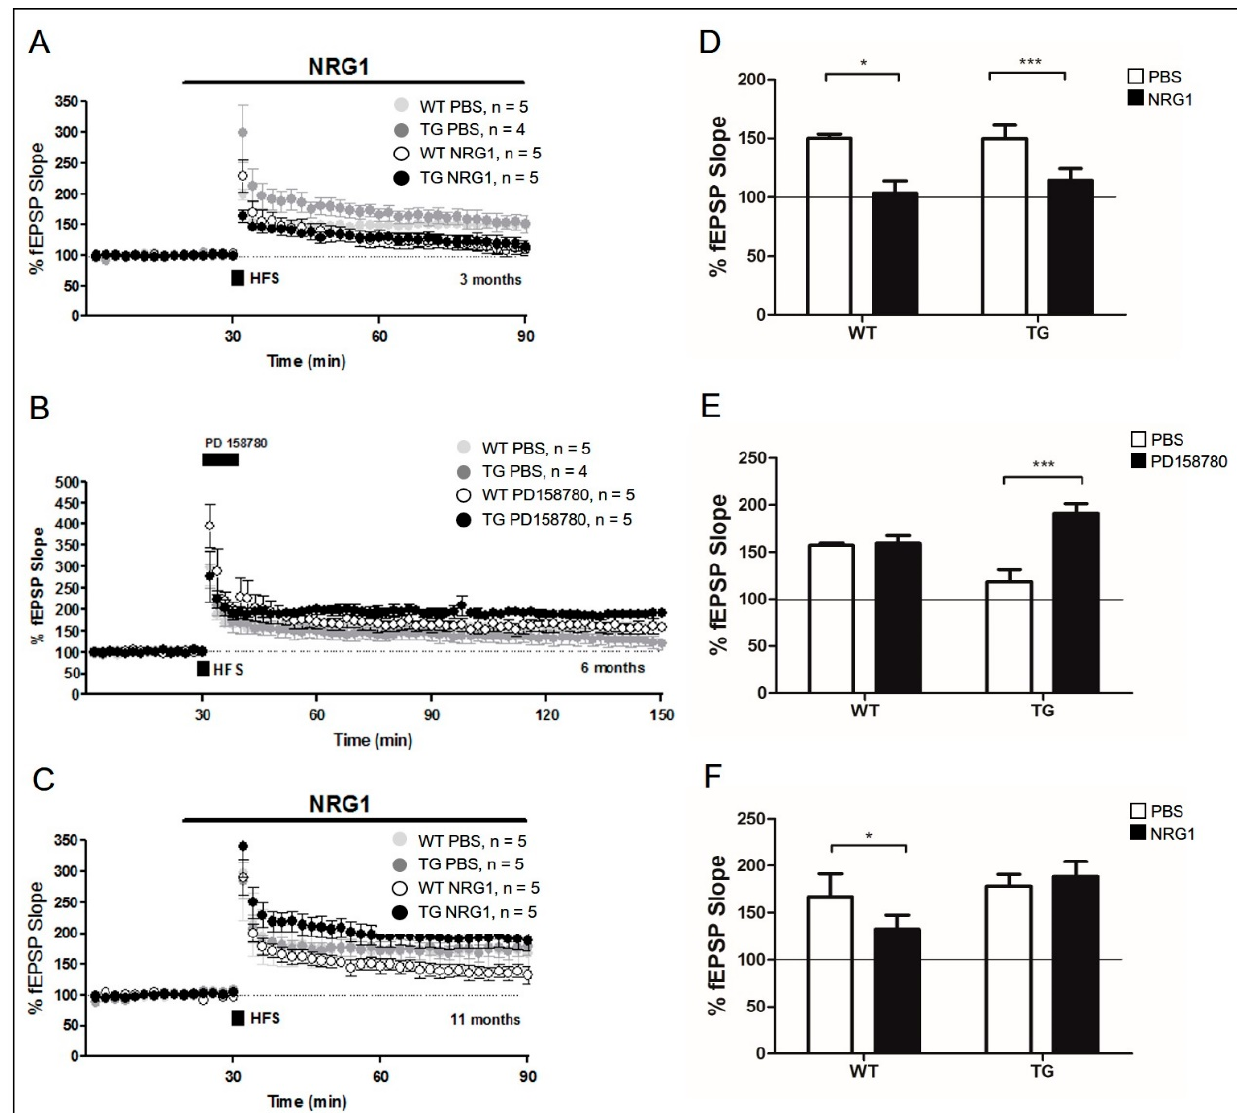
Figure 3. NRG1-expressed inhibition of LTP in aged 5xFAD mice. ( A , C ) Perfusion with 1 nM NRG1 peptide in 3- or 11-month-old WT and 5xFAD mice. ( B ) Perfusion with 10 μ M PD158780 in 6-month-old WT and 5xFAD mice. ( D – F ) Summary of the results. Data are displayed as the mean ± SEM. *, p < 0.05; ***, p < 0.0001 compared with the indicated group using unpaired t -test. fEPSP, field excitatory postsynaptic potential; WT, wild-type; TG, transgenic.